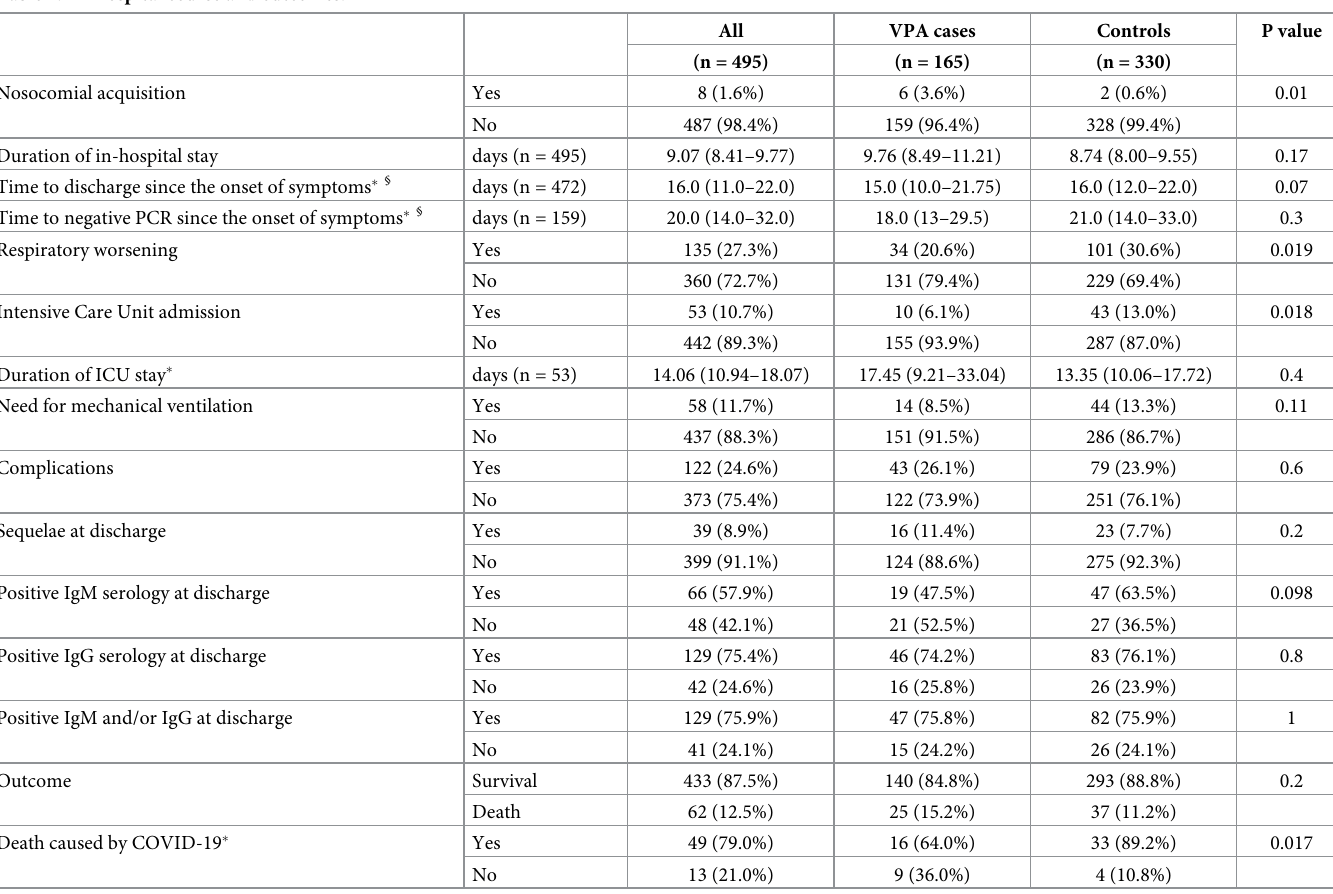
Table 4. In-hospital course and